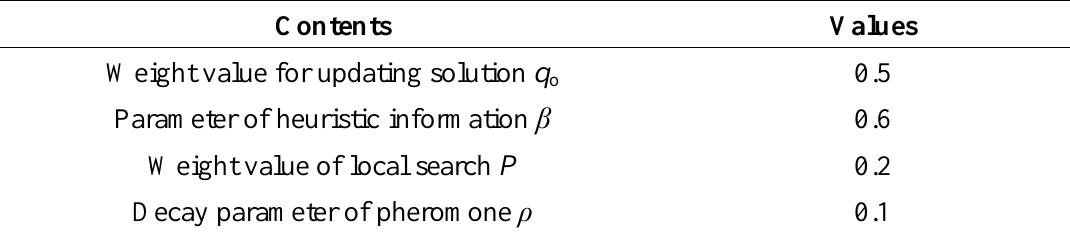
Table 3. Parameters of the ACO.